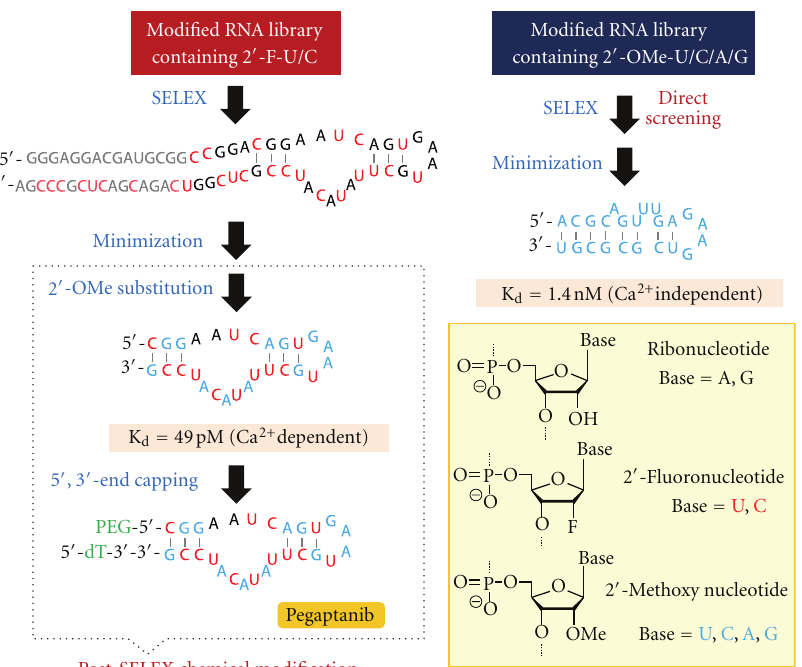
Figure 1: Preparation scheme for chemically modified nucleic acid aptamers that bind to VEGF. High nuclease-resistant 2 (cid:2) -methoxy nucleotides were introduced through Post-SELEX modification process (left), and fully modified 2 (cid:2) -OMe RNA aptamers were directly selected from a library of 2 (cid:2) -OMe transcripts